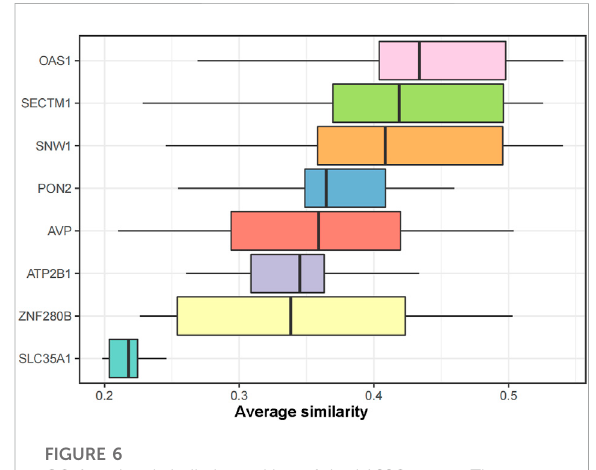
FIGURE 6 GO functional similarity ranking of the LASSO genes. The similarities in gene function distributions are summarized as boxplots. The line in the middle of the box represents the median, while the upper and lower boundaries show the upper and lower quartiles, respectively. The top three proteins with average functional similarity were de fi ned as the core